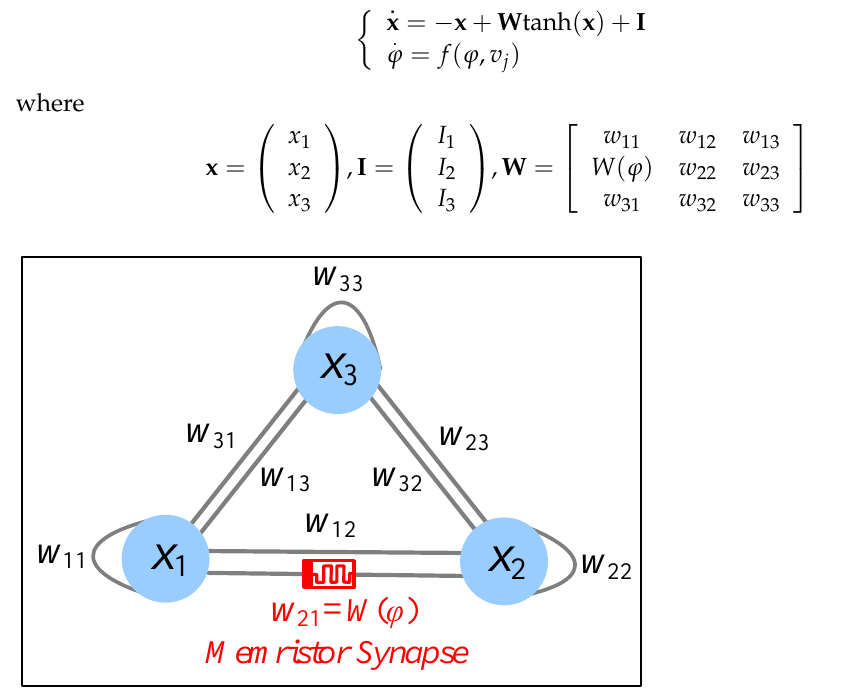
Figure 2. Connection topology of a memristor-synapse-based MHNN.